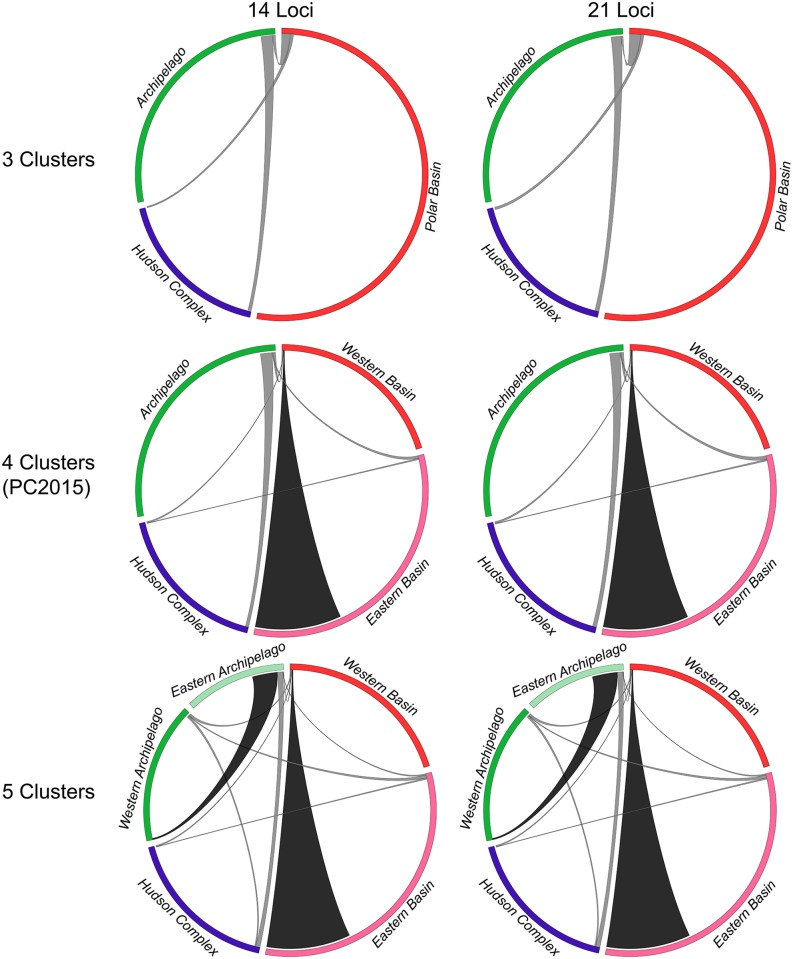
Circos plots of gene flow using 14 or 21 loci among: three clusters corresponding to our Structure results for K = 4 (excl. Norwegian Bay samples), four clusters identified in Peacock et al., 2015 [20] (excl. Norwegian Bay samples), and five clusters corresponding to our Structure results for K = 6 (excl. Norwegian Bay samples).Segment colours are as in Fig 4 and are sized proportionally to the population size estimates in Table D of S1 File, though polar bear population sizes are estimated with very broad confidence intervals, particularly in the Polar Basin, where reliable estimates are not available for most MUs. The width of each ribbon where it meets a segment on the circumference indicates the proportion of migrants into (but not out of) each region. Black ribbons are significantly directional based on non-overlapping 95% CIs of immigration rates; grey ribbons are not significantly directional.